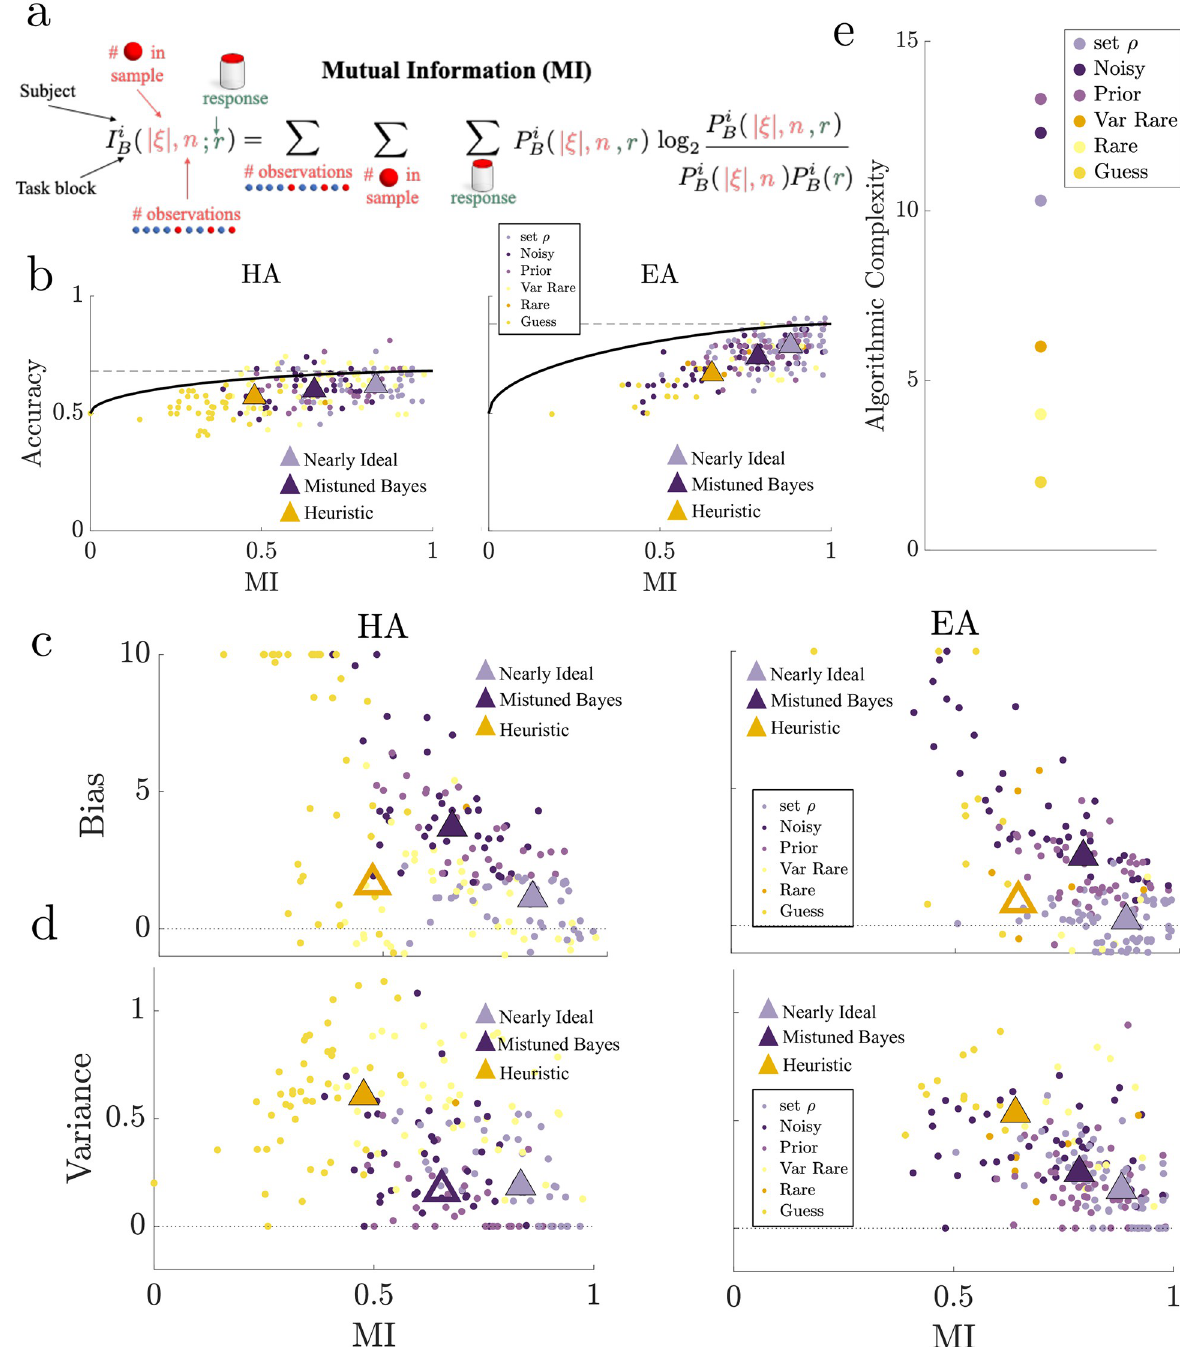
Fig 6. More complex but suboptimal human strategies exhibited more bias. a. Mutual information (MI) between the number of rare balls in a sample (| ξ |), the sample length ( n ), and the response ( r ) for each subject and block. b. Accuracy versus MI (computed as bootstrapped means from 1000 iterations per subject) for the Hard Asymmetric (HA) and Easy Asymmetric (EA) blocks. Dots represent data from individual subjects, color coded by subject’s best-fitting model described in Fig 4D. Black line represents the accuracy bound (the maximum accuracy attainable by the idea observer for a fixed MI in the limit of many trials). The dashed horizontal lines indicate the accuracy bound for maximum MI values. Note that points could exceed the asymptotic accuracy bound because the number of trials for each subject was finite. Median values for the Nearly Ideal, Mistuned Bayesian and Heuristic subject groups are indicated with triangles. In each case, filled Mistuned Bayesian and Heuristic triangles denote statistically significant differences in MI from the nearly ideal group ( p < 0.05) based on a Wilcoxon rank-sum test. Median values for all 3 groups showed increase in both accuracy and MI ranking from lowest (Heuristic), middle (Mistuned Bayesian), highest (Nearly Ideal). c- d. Relationship